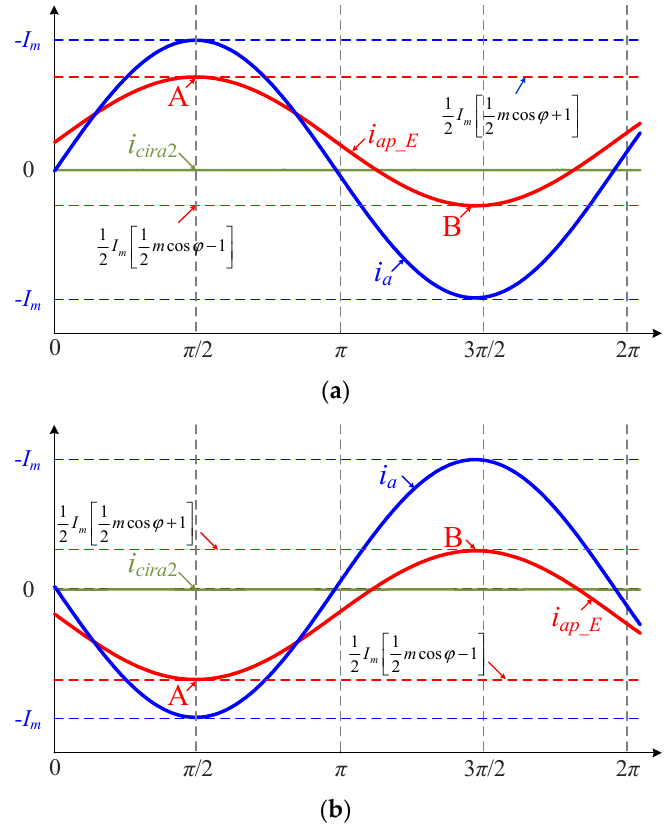
Figure 2. Schematic diagram of the arm current of the MMC with the CCEC scheme: ( a ) inverter mode; ( b ) rectifier mode.